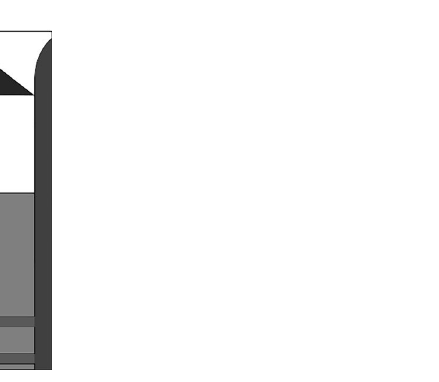
Figure 14. Schematic of the effects of H 2 on MPDF combustion.